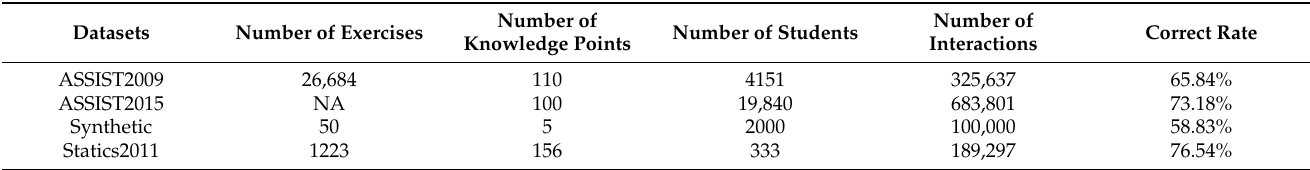
Table 1. Overview of the